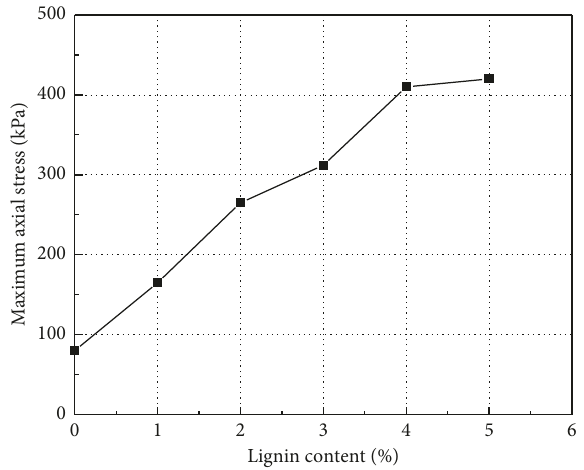
Figure 6: UCS results of treated